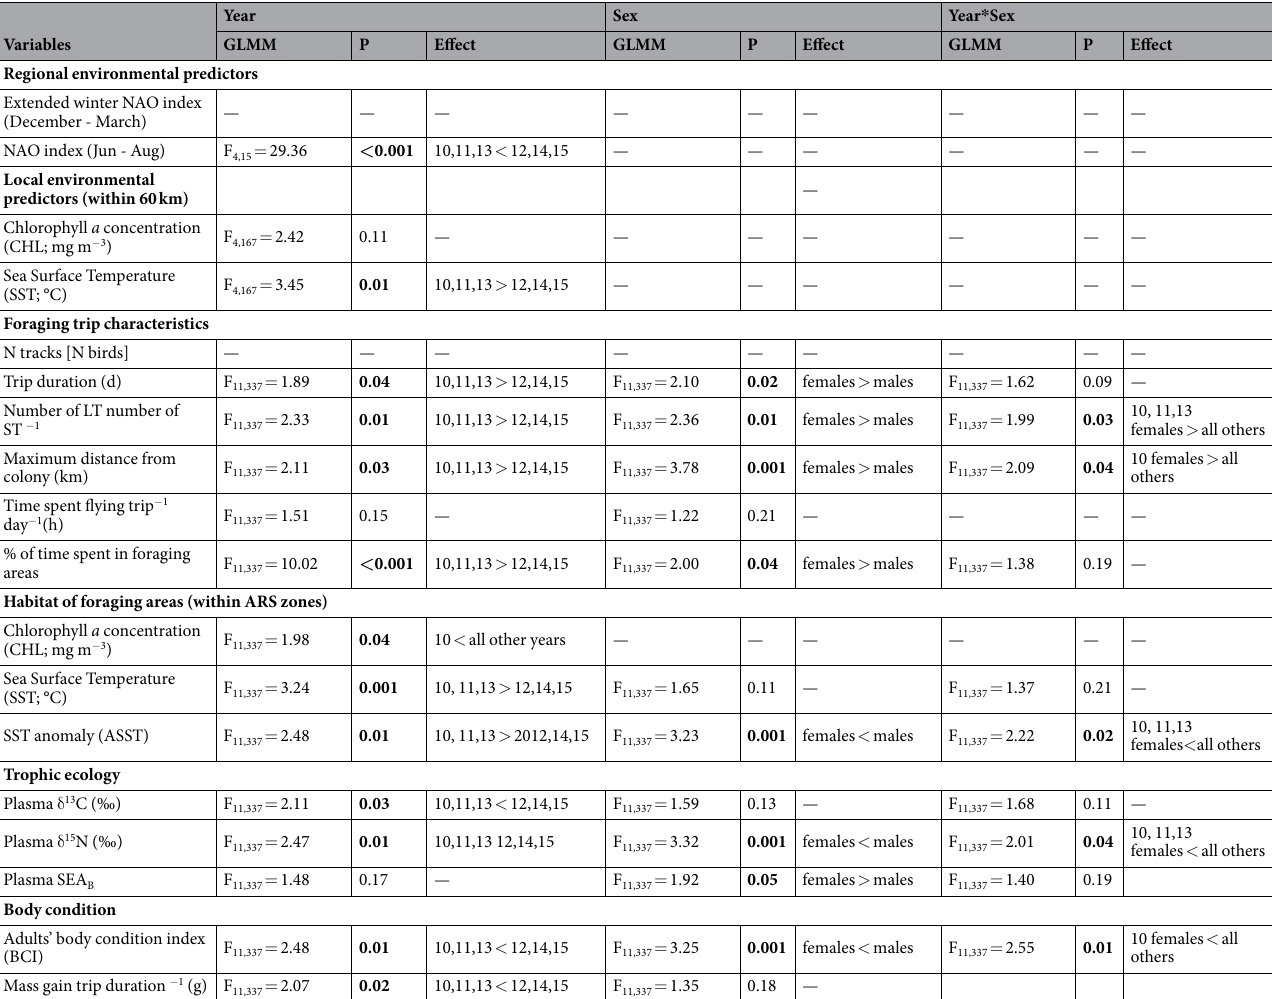
Table 2. Generalized Linear Mixed Models (GLMMs) testing the effect of the interaction between year (2010– 2015) and sex (male and female) on regional and local environmental predictors in the colony surroundings (200 km around the breeding colony), foraging habitat, trip characteristics, spatial ecology and body condition shown in Table 1. ARS – Area Restricted Search. LT – long trips ( ≥ 5 days of duration), ST – short trips ( ≤ 4 days of duration) as defined by ref. 24. Study years represented by the last two digits. The individual was used as a random effect to avoid pseudo-replication issues. Significant results in bold. Effect was evaluated with Post-hoc multiple comparisons with Bonferroni